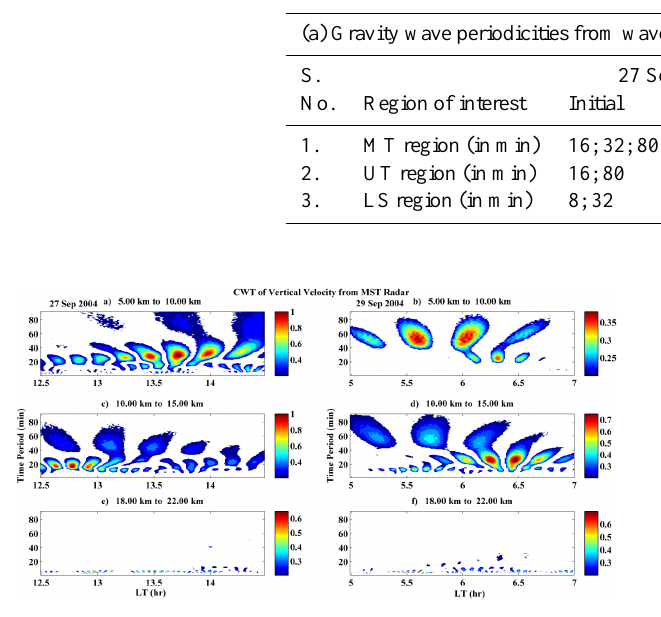
Figure 6A. CWT of vertical wind velocities (ms -1 ) before convection in the height regions 5-10 687 Fig. 6a. CWT of vertical wind velocities (ms − 1 ) before convection in the height regions 5–10km (a and d) , 10–15km (b and e) and 18– km (a and d), 10-15 km (b and e) and 18-22 km (c and f) for 27 September 2004 (left panel) and 688 22km (c and f) for 27 September 2004 (left panel) and 29 Septem- 29 September 2004 (right panel), respectively. 689 ber 2004 (right panel), respectively.